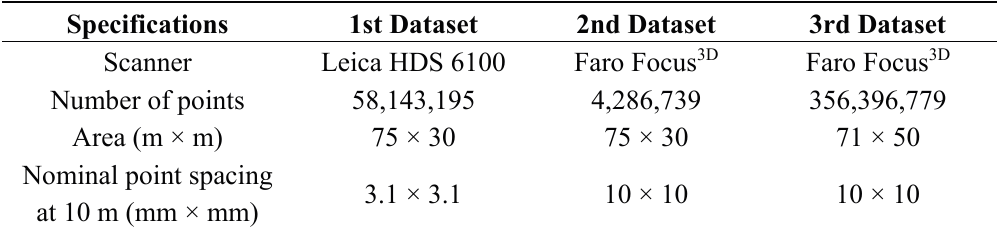
Table 2. Specifications of three datasets used in this research.